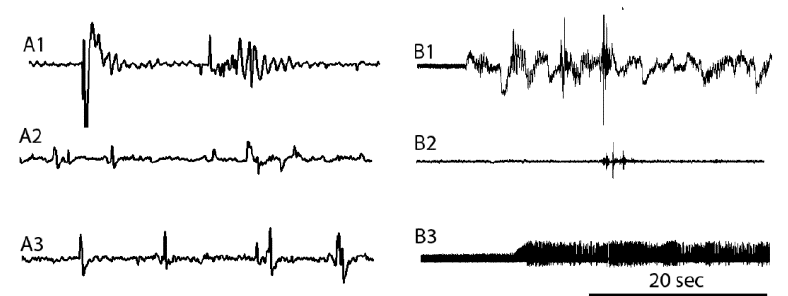
Figure 8. EMG traces of the closer muscle. Recordings from the chela of crab ( A) and crayfish ( B ) before ( A1 , B1 ), during immersion in an ice slurry ( A2 , B2 ) and after ( A3 , B3 ) being returned to their original holding tanks. The closer muscle was stimulated to contract by rubbing a wooden rod on the teeth on the inside of the jaw of the chela to stimulate a sensory-CNS-motor nerve circuit. The traces shown are during the time of sensory stimulation. Note the responses are dampened while the crab ( A2 ) and crayfish ( B2 ) are in the ice slurry for 2 min. Upon returning the crab ( A3 ) and crayfish ( B3 ) to their original warmer water, the EMG traces regained their strength and maintained firing while the jaws were clamped on the wooden rod ( B3 ). The traces shown are from the same crab or crayfish during the different situations. The 20 s scale bar applies to all traces.